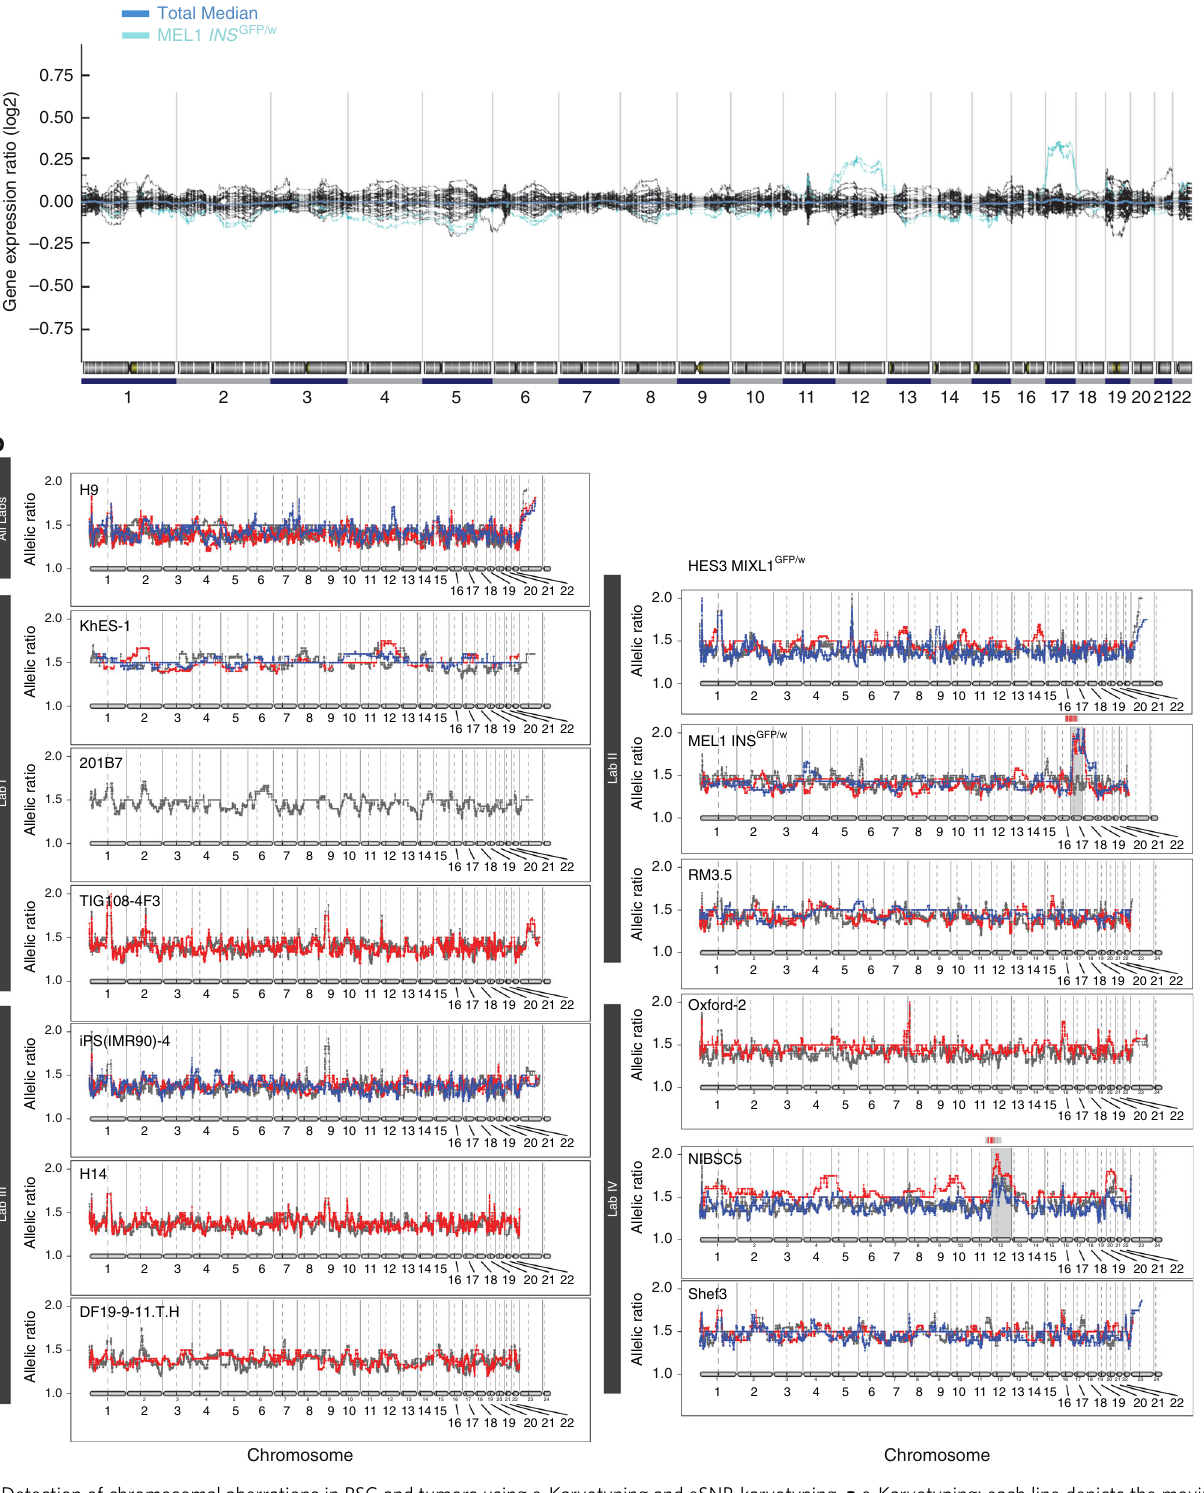
Fig. 1 Detection of chromosomal aberrations in PSC and tumors using e-Karyotyping and eSNP-karyotyping. a e-Karyotyping: each line depicts the moving average plots of global gene expression in 13 different cell lines over 300-gene bins. The gene expression of 12 cell lines (black lines) was close to the total mean, suggesting a normal karyotype. In contrast, all replicates of the MEL1 INS GFP/w (cyan) cell line showed considerable upregulation of genes from both chromosomes 12 and chromosome 17, suggesting that it harbors an additional copy of these chromosomes. b eSNP-karyotyping: detection of chromosomal aberrations in tumors using eSNP-karyotyping. Each line depicts the moving average (over 151 SNPs) of gene expression generated from RNA-seq data of tumor derived from 13 different cell lines (one plot per source cell line). Colors represent tumor replicates. Only tumors derived from MEL1 INS GFP/w and NIBSC5 show an altered allele ratio in both replicates, suggesting an aberrant karyotype with additional copies of chromosomes 17 and 12,